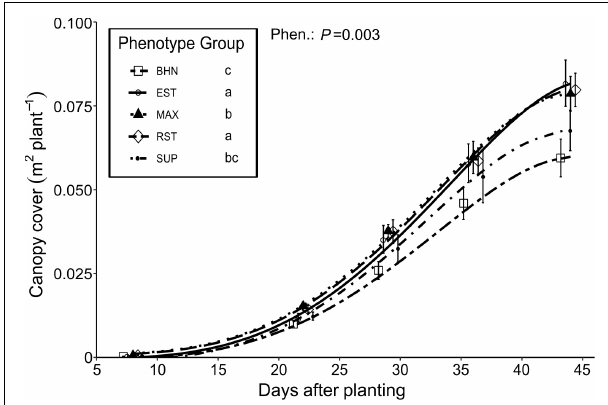
FIGURE 5 | Changes in canopy cover of four grafted rootstocks (Estamino, Maxifort, RST-04-106-T, and Supernatural) and one cultivar (BHN-589) grown under field conditions. All rootstocks were grafted with BHN-589. All canopies were measured at 8, 22, 29, 36, and 44 days after planting ( x -values staggered for visual clarity). Canopy cover values were inverse-negative-log transformed prior to slope comparisons. Data presented is untransformed. Points are mean ± standard error ( n = 7–8). Legend information followed by different letters are mean-slopes statistically different at P <